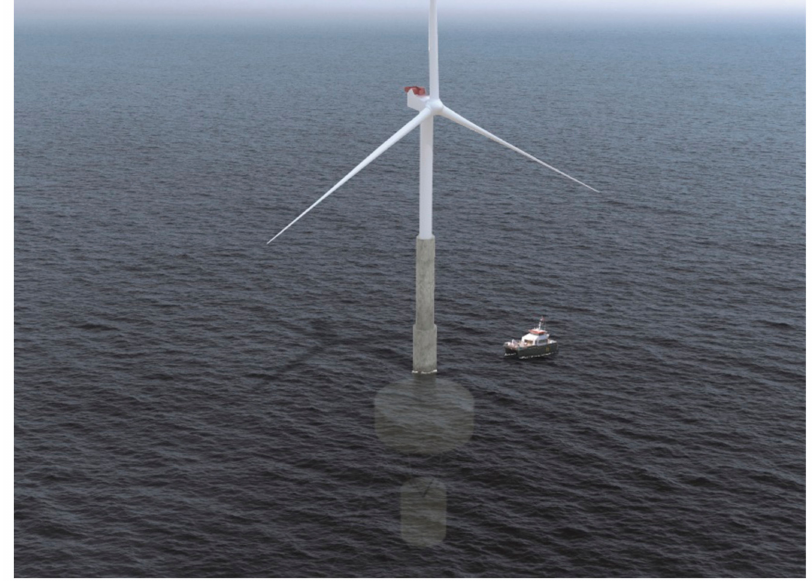
Figure 3. Telewind ® platform. Source: Figure courtesy of Esteyco